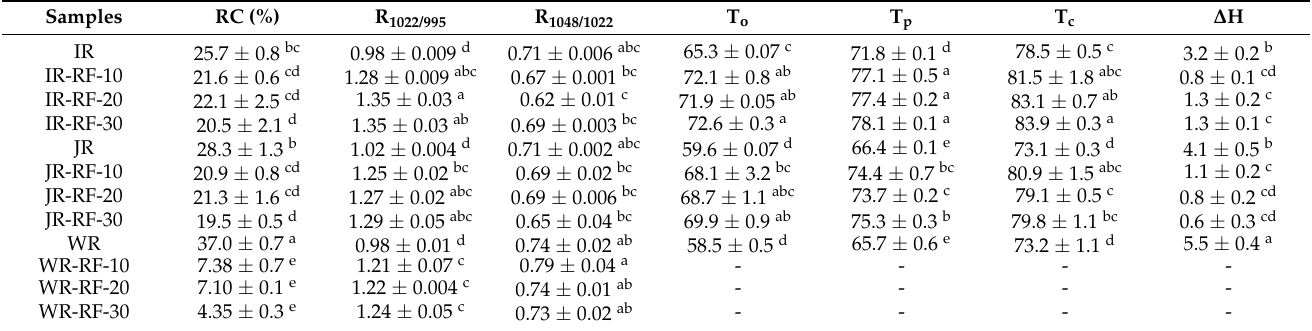
Different letters in the same column indicate a significant difference ( p < 0.05). IR: indica rice; JR: japonica rice, WR: waxy rice; RF: radio